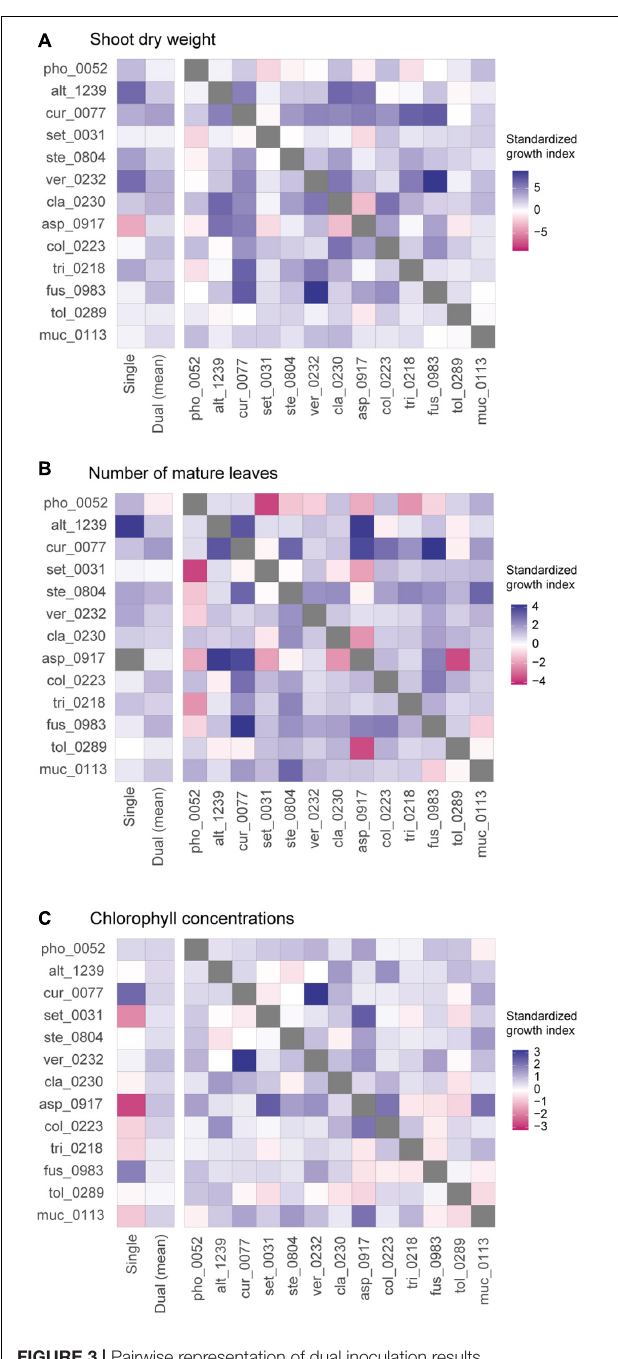
FIGURE 3 | Pairwise representation of dual inoculation results. (A) Standardized growth index in terms of shoot dry weight for each pair of fungal isolates. Single-inoculation effects and mean effects across the dual inoculation assays are shown for each fungal isolate in the left. (B) Standardized growth index in terms of the number of mature leaves. (C) Standardized growth index in terms of chlorophyll concentrations.